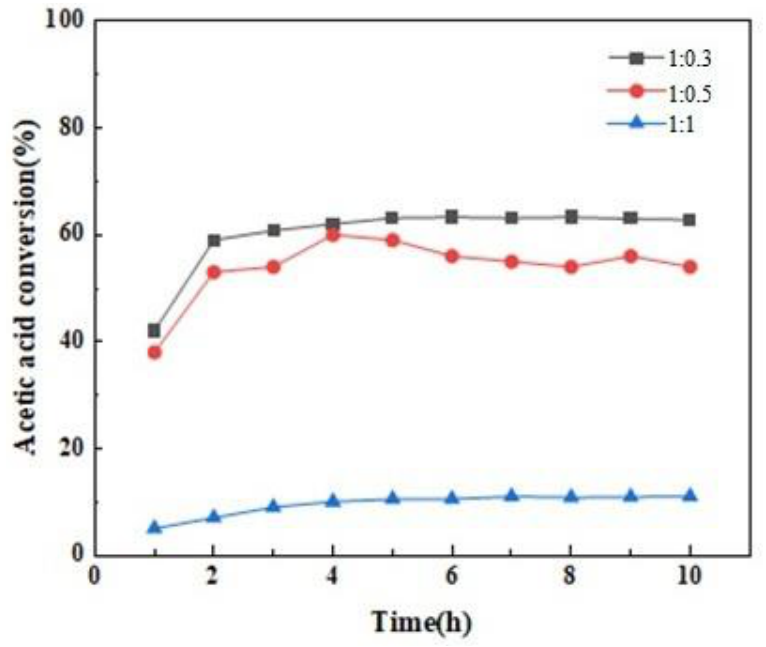
Figure 1. Acetic acid conversion of three catalysts prepared by pyrolysis of three different MOF-5 precursors at 750 °C when the mass ratio of Zn(NO 3 ) 2 ·6H 2 O to H 2 BDC was 1:1, 1:0.5, 1:0.3.